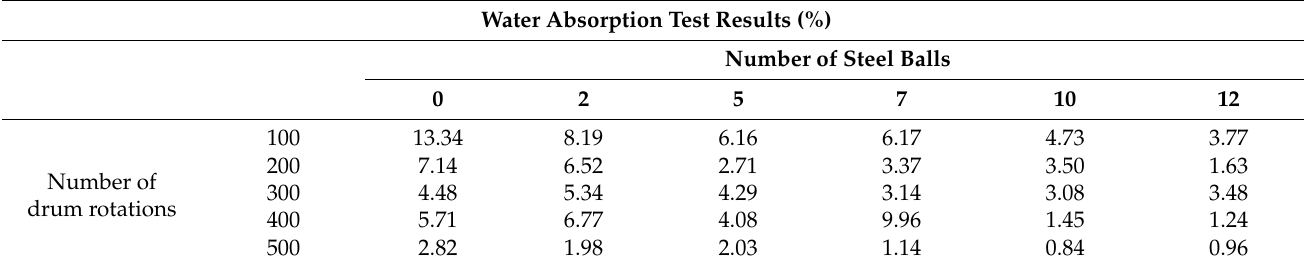
Table 3. The water absorption values of processed 11.2–22.4 mm RA after the application of BMM [21]. Water Absorption Test Results